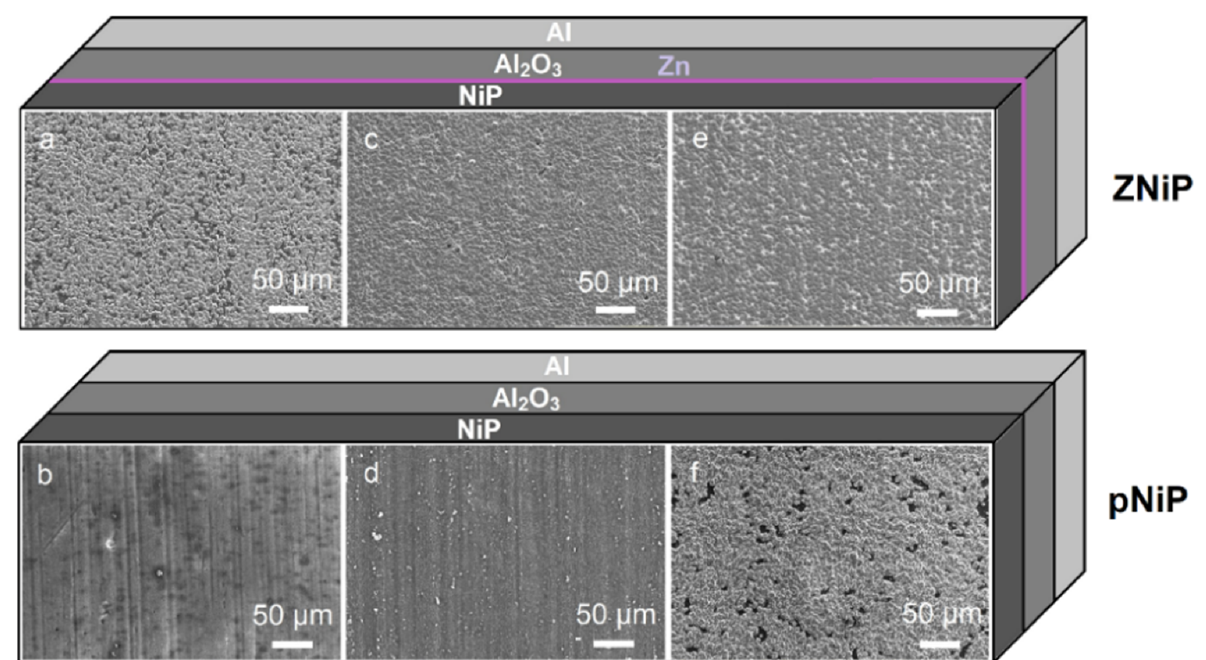
Figure 3. SEM images of Ni-P deposited on NAC ( a , c , e ) with zincate treatment and ( b , d , f ) without zincate treatment: ( a , b ) 5 min, ( c , d ) 10 min, ( e , f ) 15 min.